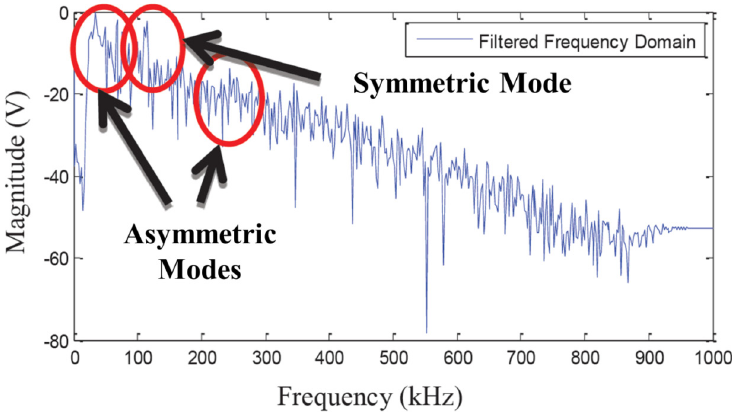
Figure 17. The voltage output of the YCOB acoustic emission sensor as a function of frequency at 1,000 °C [94] (copyright © 2013 by the